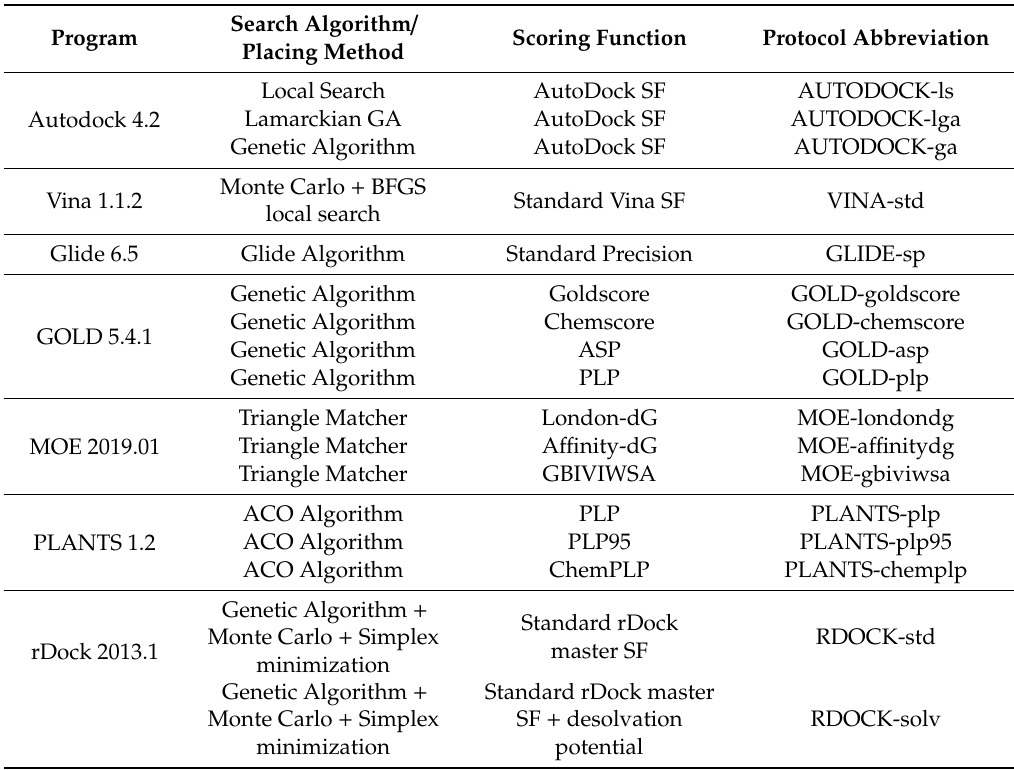
Table 1. List of docking protocols used in the